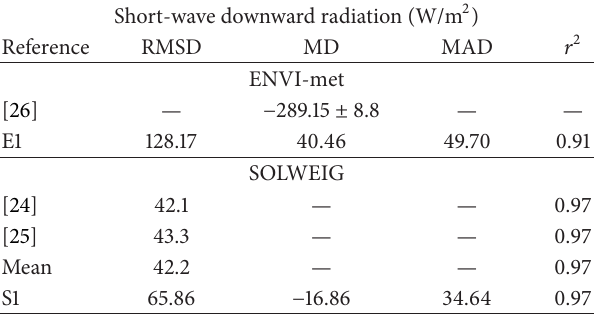
Table10:Overviewofdeviationsinshort-wavedownwardradiation between simulation and observation in other studies. For further explanation refer to Table 9.